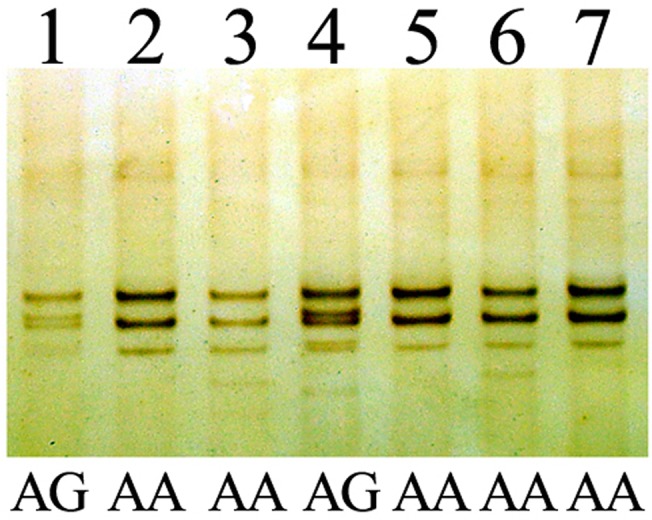
The single-strand conformation polymorphism analysis of PCR products in A669TG/G669TG.Lanes 1–7 were PCR products from different individuals.